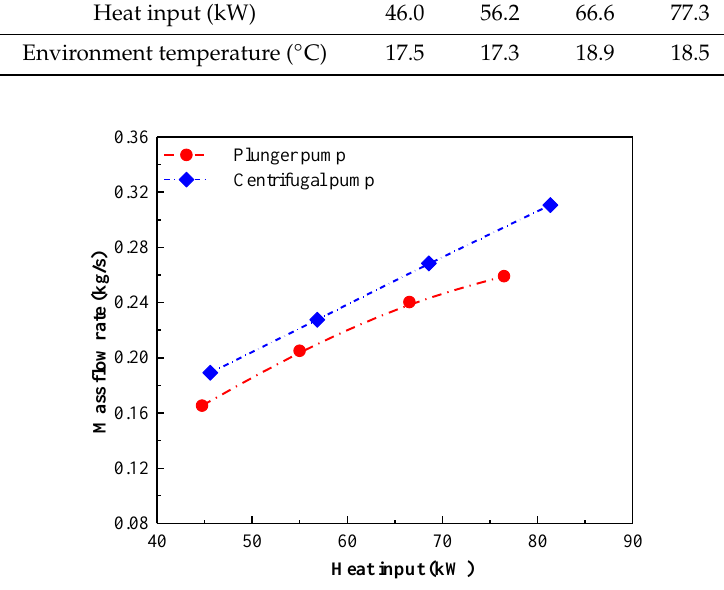
Figure 4. Mass flow rates with heat input using the plunger pump and centrifugal pump.